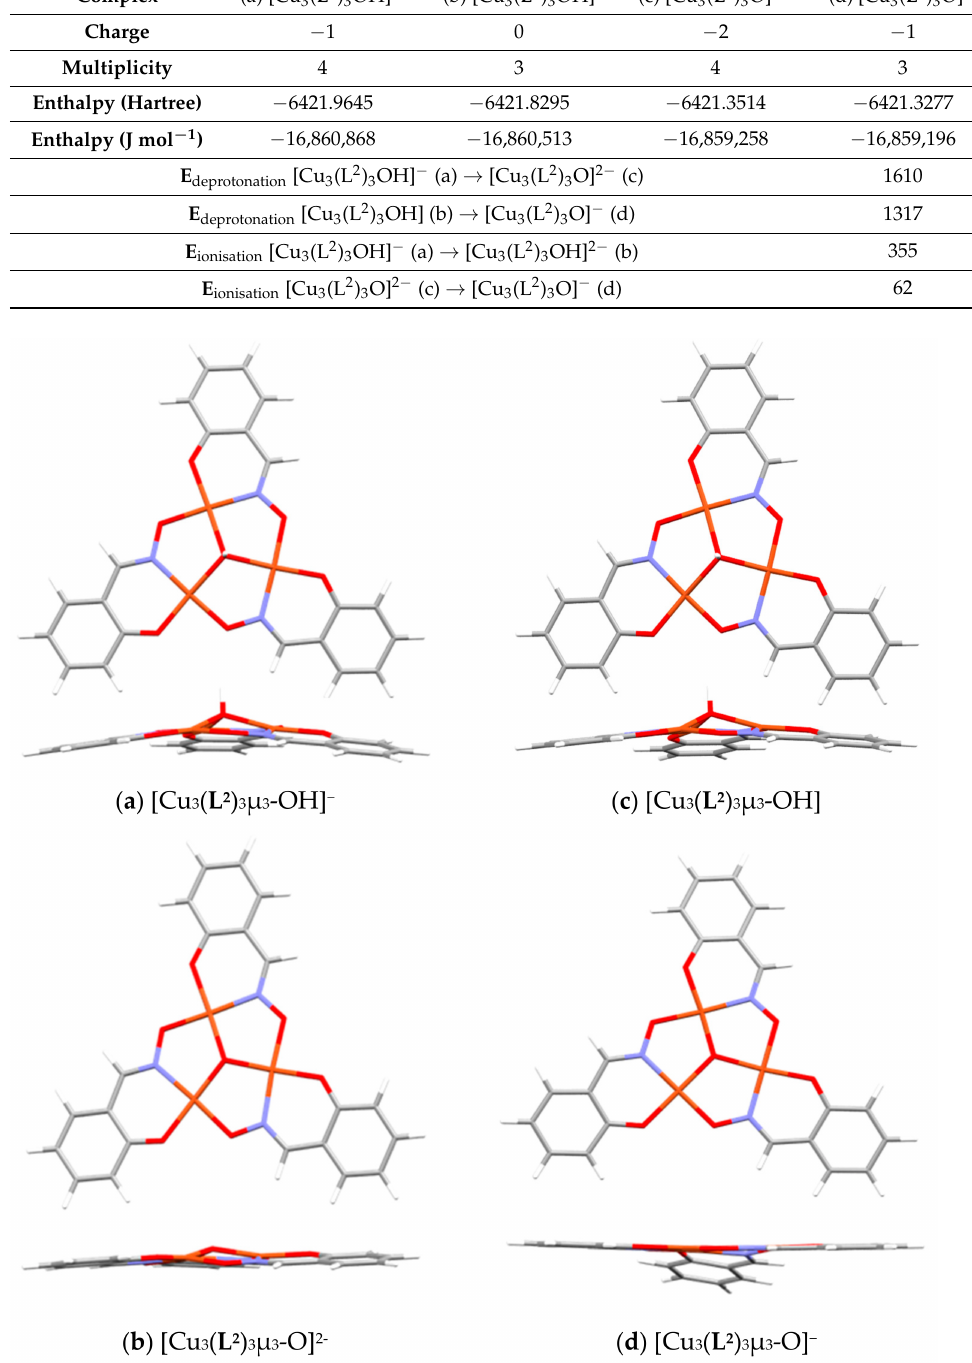
Figure 15. The energy-minimized structures for ( a ) [Cu 3 ( L 2 ) 3 µ 3 -OH] − , ( b ) [Cu 3 ( L 2 ) 3 µ 3 -OH], ( c ) [Cu 3 ( L 2 ) 3 µ 3 -O] 2 − and ( d ) [Cu 3 ( L 2 ) 3 µ 3 -O] −